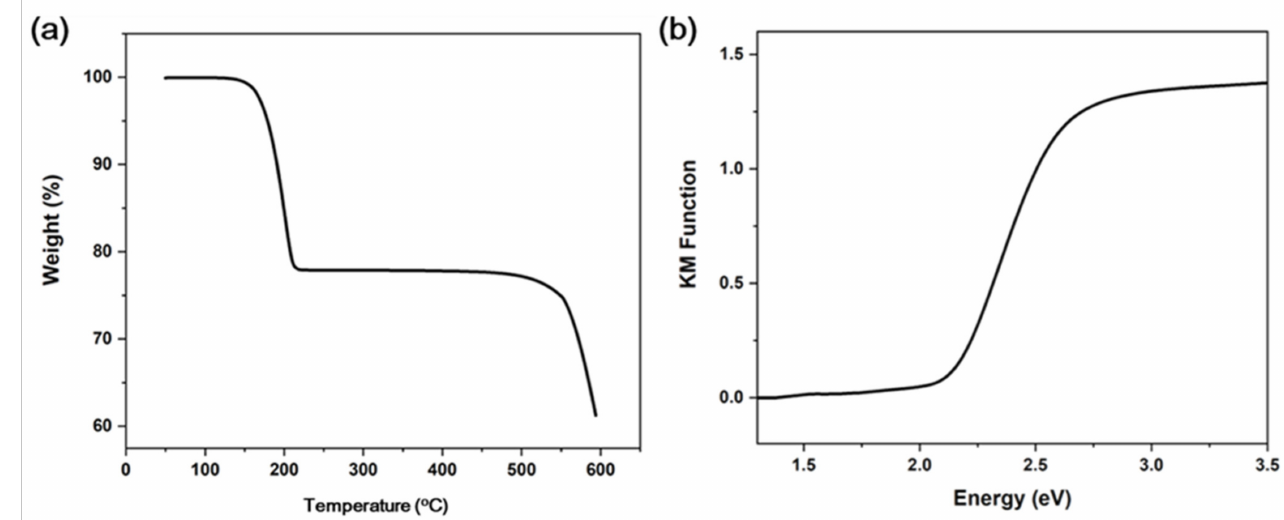
Figure 2. ( a ) TGA plot of 1 . ( b ) UV-vis absorption spectrum of 1 .